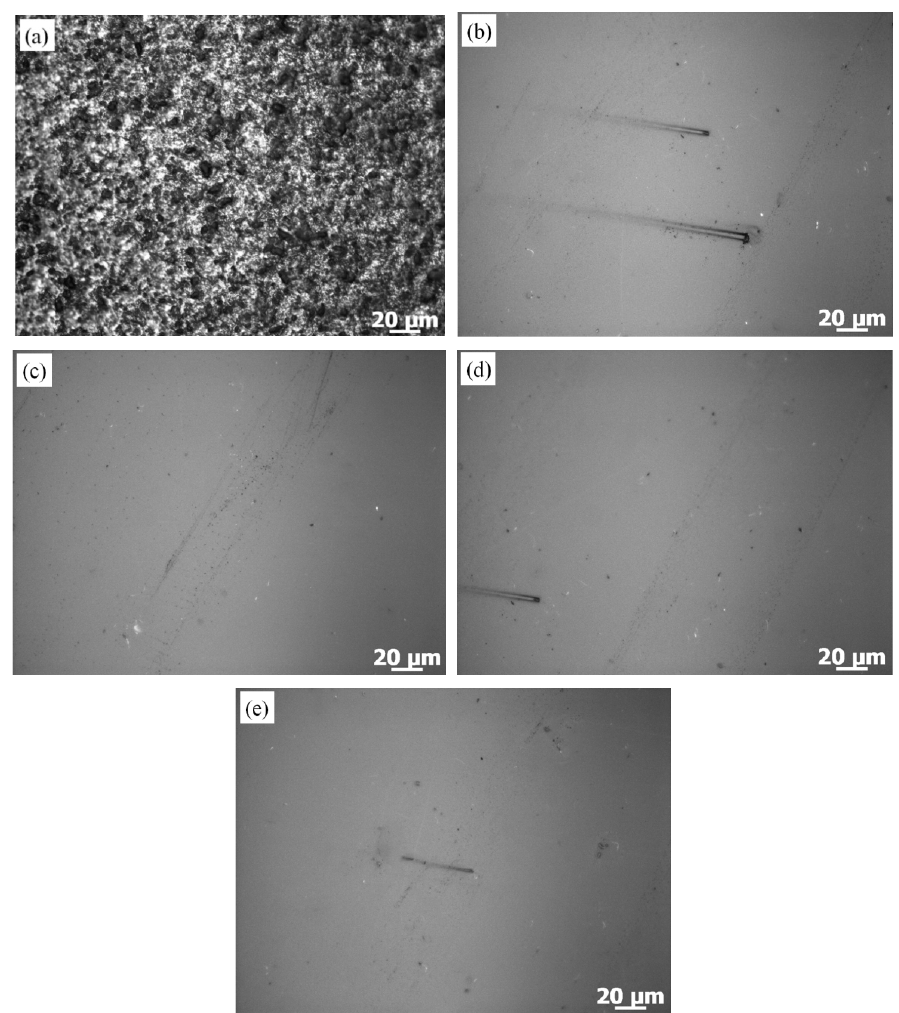
Figure 10. The surface morphologies with different rotational speeds of the workpiece: ( a ) initial surface morphology, ( b ) n = 150 rpm, ( c ) n = 300 rpm, ( d ) n = 450 rpm, ( e ) n = 600 rpm.